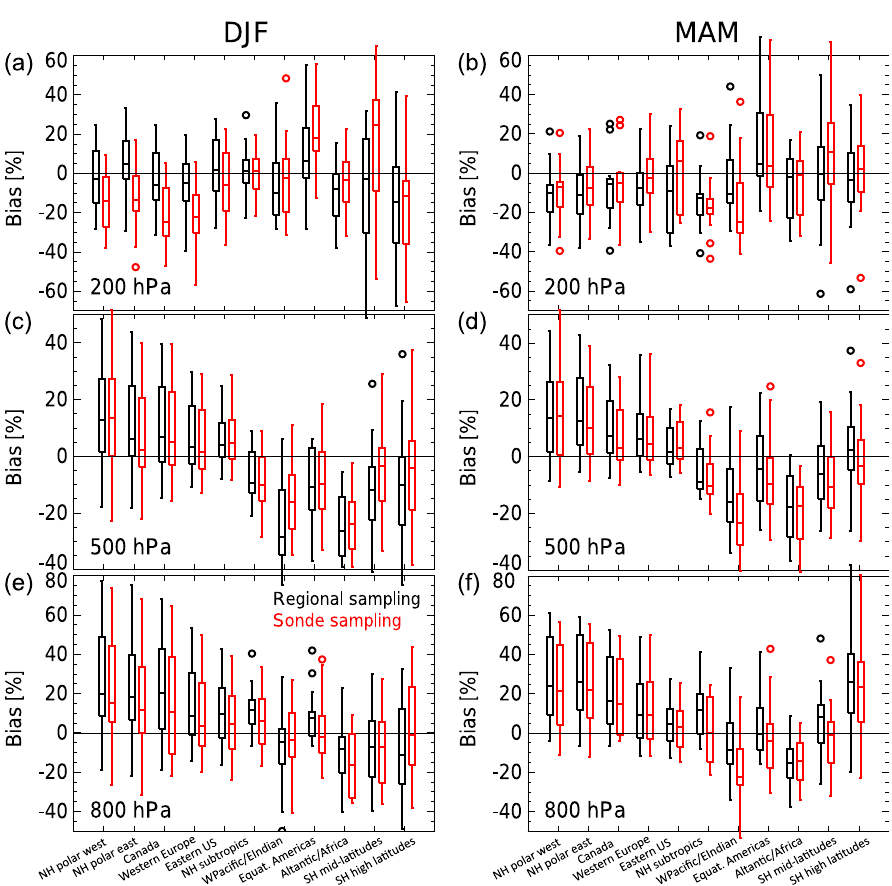
Figure 9. Box plots of relative model–reanalysis difference for seasonal mean concentration for DJF (a, c, e) and MAM (b, d, f) at 200hPa (a, b) , 500hPa (c, d) , and 800hPa (e, f) . Results are shown for ACCMIP model simulations for 11 regions (cf. Table 3 and Fig. 8). Black box shows model minus reanalysis difference for regional mean concentration (averaged over all model grid points); red box shows model minus reanalysis at the ozonesonde